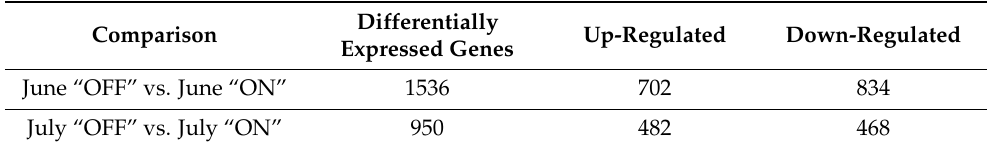
Table 2. The table provides the number of total genes, up- and down-regulated genes in fruits during the current year non-bearing shoot (“OFF”) and bearing shoots